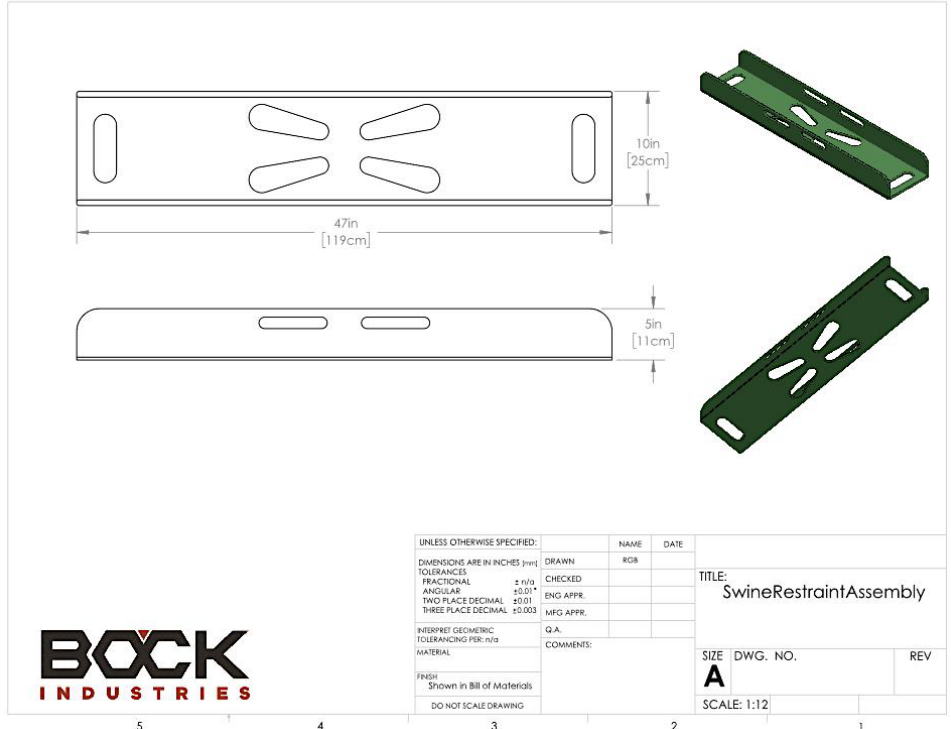
Figure 1. Bock Industries (Philipsburg, PA, USA) restrainer.